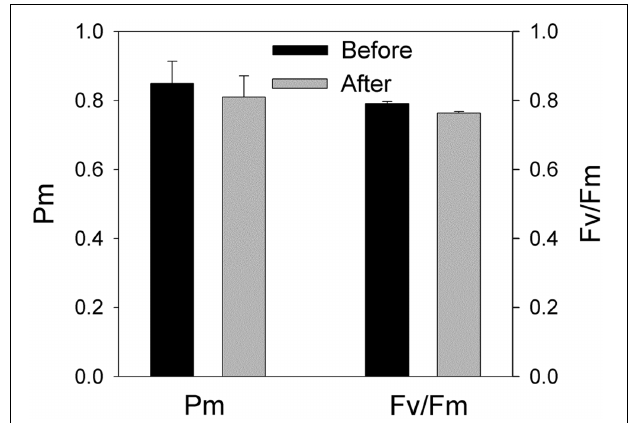
FIGURE 2 | Effects of moderate fluctuating light on PSI and PSII activities. The maximum photo-oxidizable P700 ( P m ) and the maximum quantum yield of PSII ( F v / F m ) were measured before and after treatment with moderate fluctuating light as shown in Figure 1 . Values were measured following 30 min dark adaptation. The means ± SE were calculated from at least four plants.